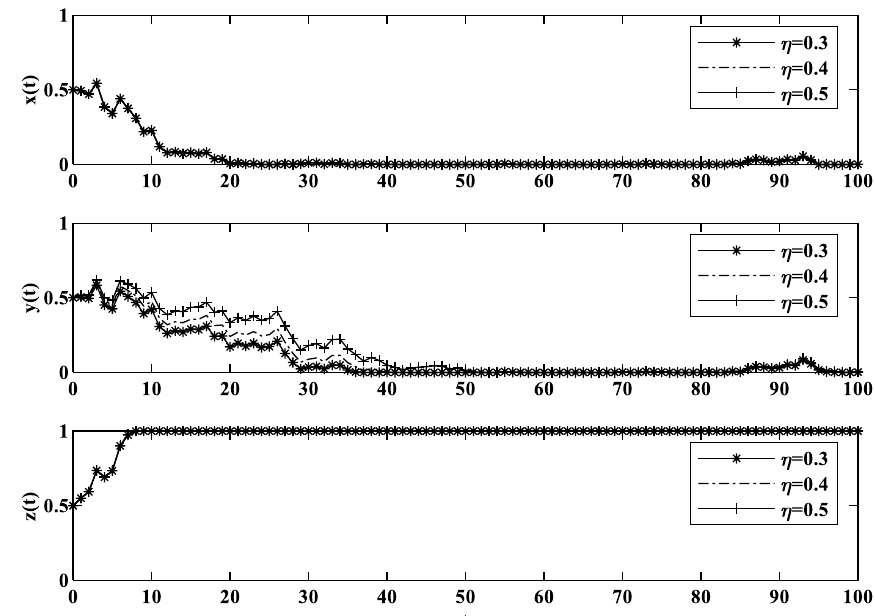
Fig. 8 Impact of ratio of financial budget on evolutionary process under scenario